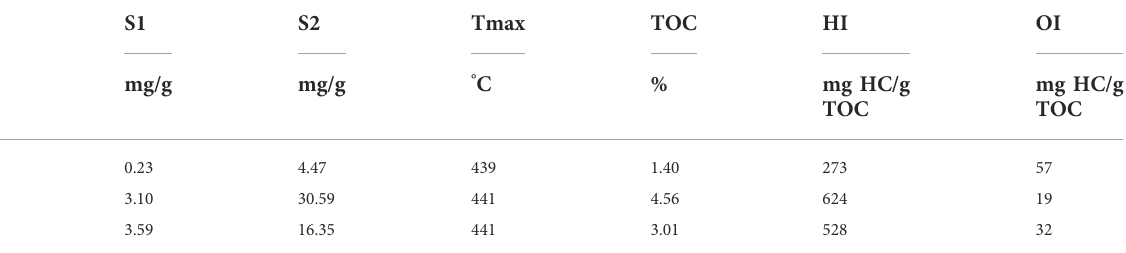
TABLE 1 Pyrolysis characteristics of each